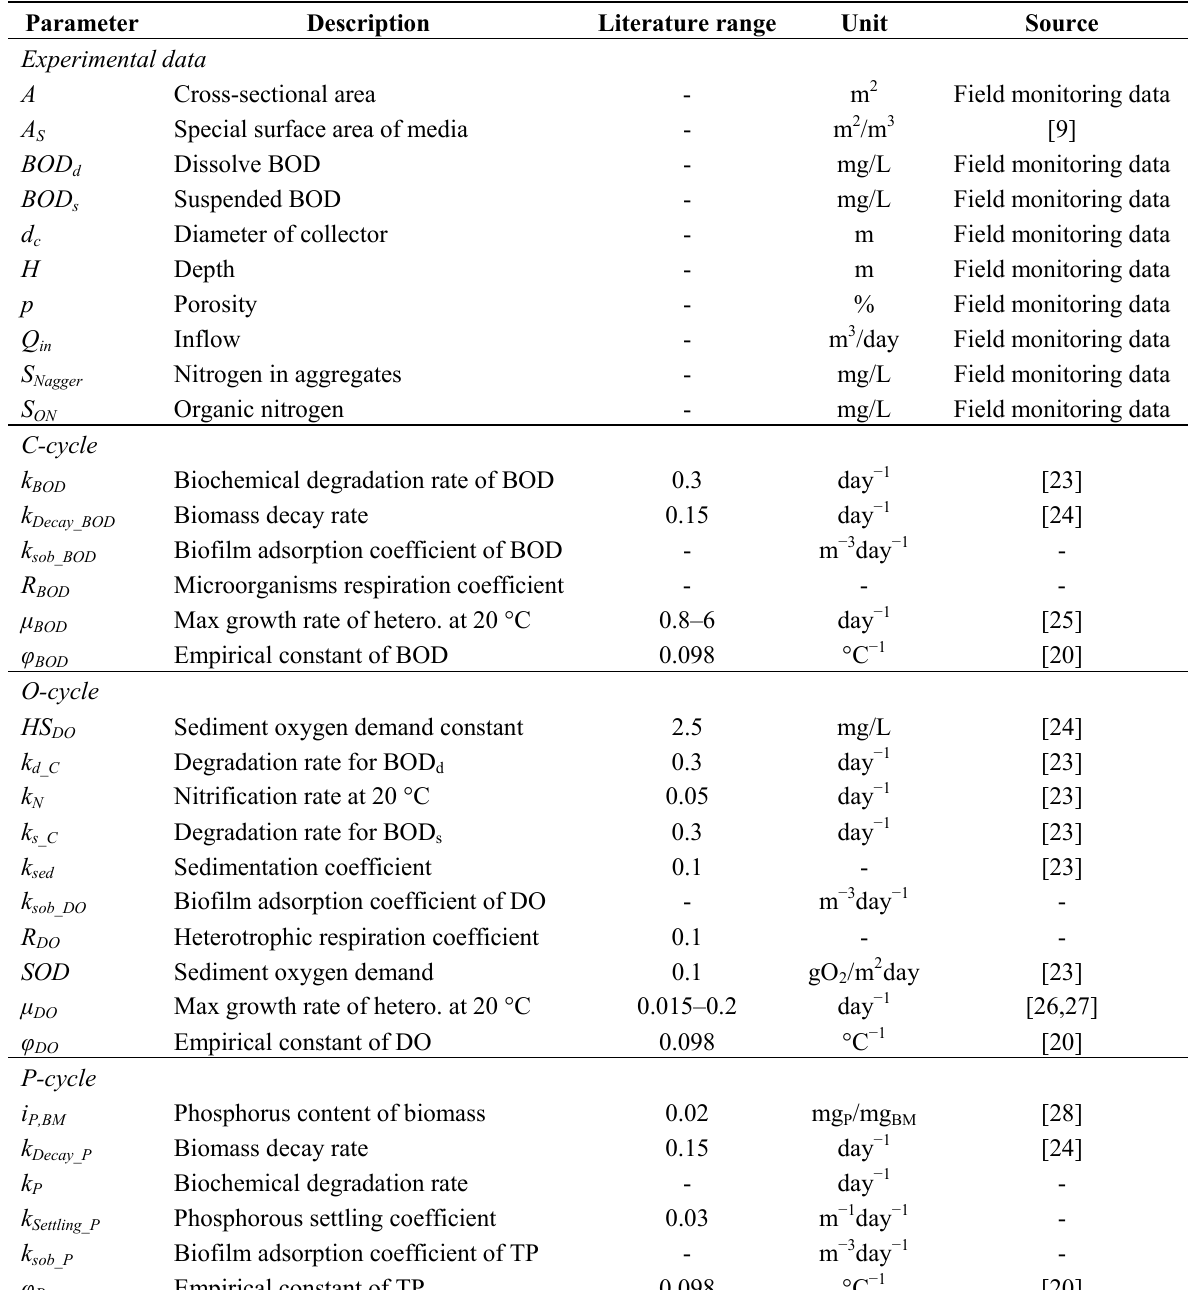
Table 5. Summary of parameters and constants of different biochemical processes of CW waste treatment involved in the simulated model (experimental data, C-cycle, O-cycle, P-cycle and SS removal, N-cycle, biofilms, temperature coefficients and half-saturation